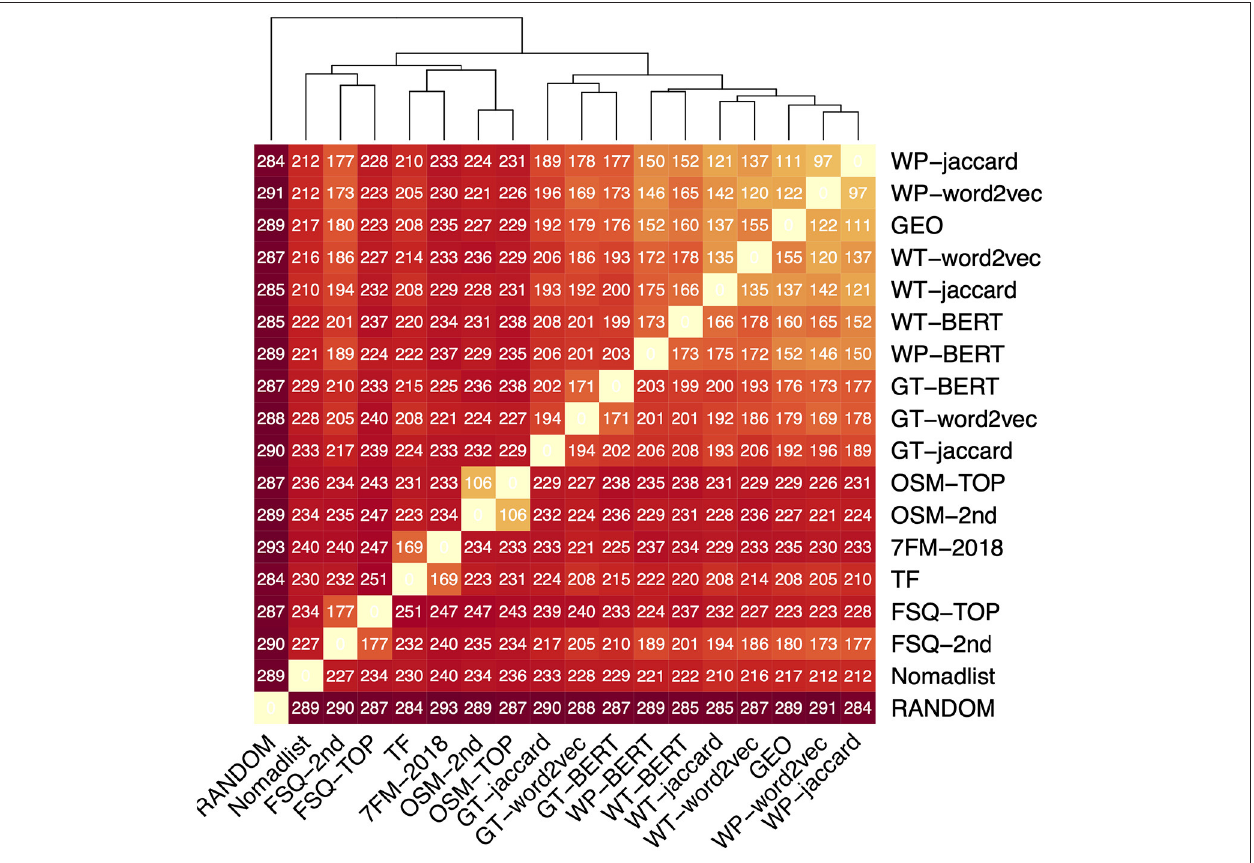
FIGURE 4 | Crosswise-analysis of all data models using Kendall’s Tau method. The entries are sorted using hierarchical clustering; the dendrogram reveals families of data sources. The colors are scaled according to Kendall’s Tau with the bright yellow corresponding to 0 (the diagonal) and dark red representing no correlation